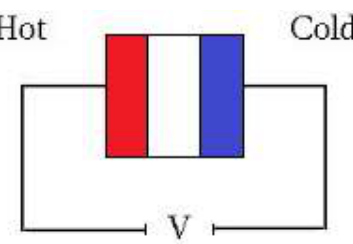
Figure 3. Schematic presentation of the Seebeck coefficient determination. Table 1. Boiling points of the solvents.